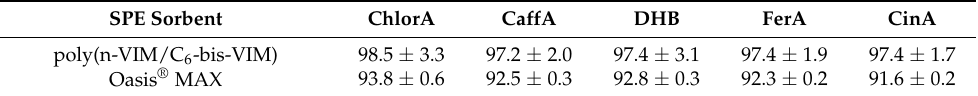
Table 2. Recovery comparison of the developed poly(n-VIM/C 6 -bis-VIM) polymer with a monomer to crosslinker ratio of 11.50 to 1 and the commercially available SPE sorbent Oasis ® MAX. SPE Sorbent ChlorA CaffA DHB FerA CinA poly(n-VIM/C 6 -bis-VIM)